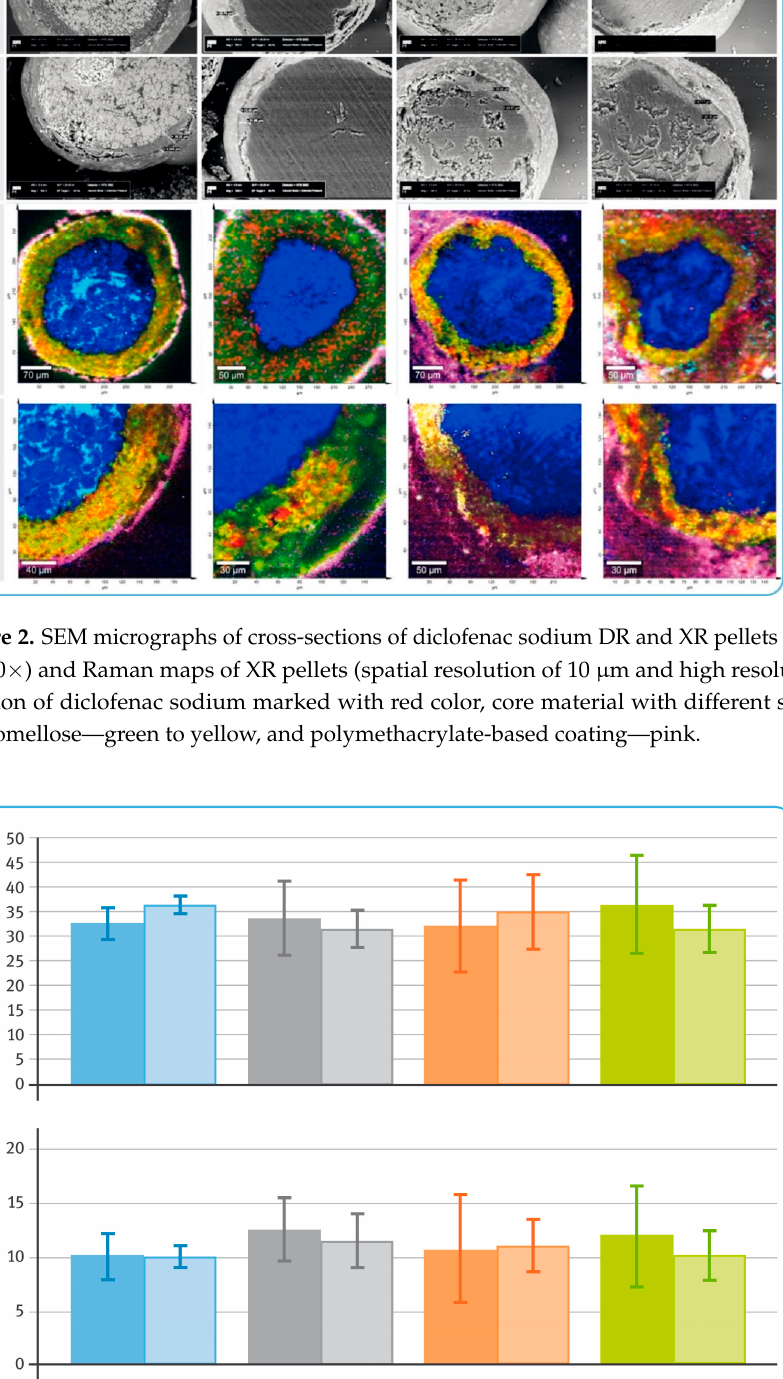
Table 4. Content of diclofenac sodium in drug-loaded pellets (mean of 3 independent determinations). Inert Cores